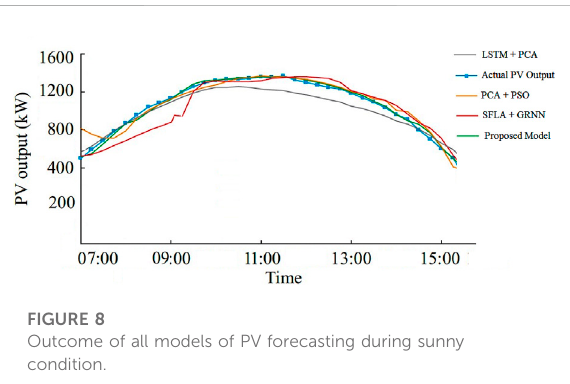
FIGURE 8 Outcome of all models of PV forecasting during sunny